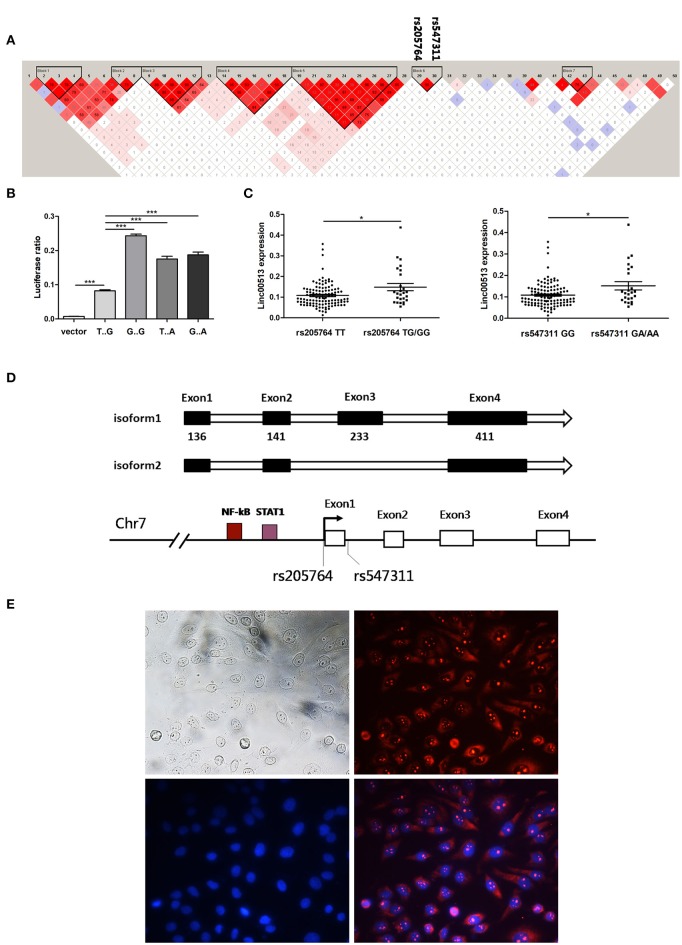
Rs205764 and rs547311 could modulate the expression of linc00513 expression. (A) LD patterns of 50 human disease related SNPs in the gene region. Two haplotype blocks were constructed based on the strength of LD in each gene region. (B) Luciferase reporter gene assay of linc00513 promoter. 1.12 kb approximate to the TSS of linc00513 (−684 to +439) was cloned into the pGL3-basic luciferase vector. HeLa cells were transfected with linc00513 promoter or control pGL3-basic luciferase reporter vector and Renilla reporter vector. 24 h after transfection, cells were lysed and ratio of firefly to Renilla luciferase activity was analyzed. The data shown are means ± SEM and are representative of three independent experiments performed in triplicate or quadruplicate. P-values were analyzed with two-tailed unpaired t-test. ***indicates p < 0.001. Rs205764 G allele and rs547311 A allele improved linc00513 promoter activity. (C) Relative expression level of linc00513 was measured for the different genotypes of rs205764 and rs547311 in neutrophils from 139 SLE individuals (rs205764: TT, n = 113; TG, n = 24; GG, n = 2. rs547311: GG, n = 115; GA, n = 22; AA, n = 2.) P-values were analyzed with non-parametric Mann-Whitney U-test. *indicates p < 0.05. (D) Gene structural models of linc00513 as determined by 3′ and 5′ RACE. (E) Nuclear and plasma distribution of linc00513 in hela cells as showed by FISH. Upper left: white light; upper right: linc00513 (red); lower left: DAPI (blue); lower right: merge of linc00513 and DAPI.